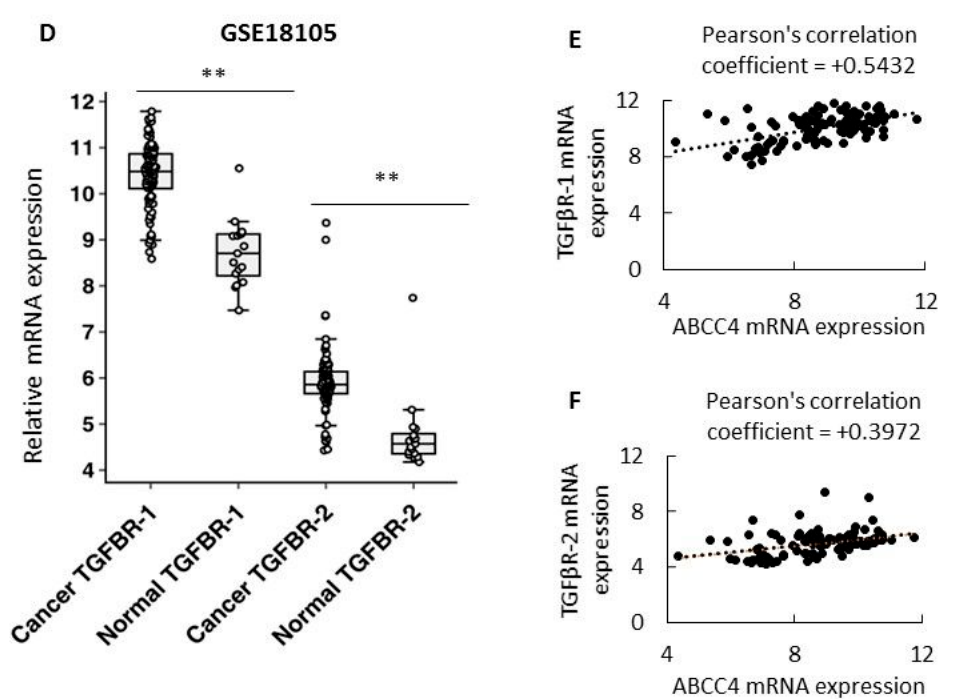
Figure 2. TGF β pathway and ABCC4 mRNA expression analysis. TGF β 1 / 2 ( A ) and TGF β R1 / 2 ( D ) expression analysis in CRC patient tissue. Data obtained from the GSE18105 data set, cancer n = 94, normal n = 16. Correlation of ABCC4 expression and TGF β 1 ( B ) or TGF β 2 ( C ) or TGF β R1 ( E ) or TGF β R2 ( F ) expression, n = 110 [20]. Sample data sets were tested with the Shapiro–Wilk test, presenting a normal distribution, followed by the T -test. Pearson’s correlation coe ffi cient (PCC): 0–0.25 no PCC, 0.25–0.5 low PCC, 0.5–0.75 moderate PCC, 0.75-1 strong PCC. Comparison of Pearson’s and